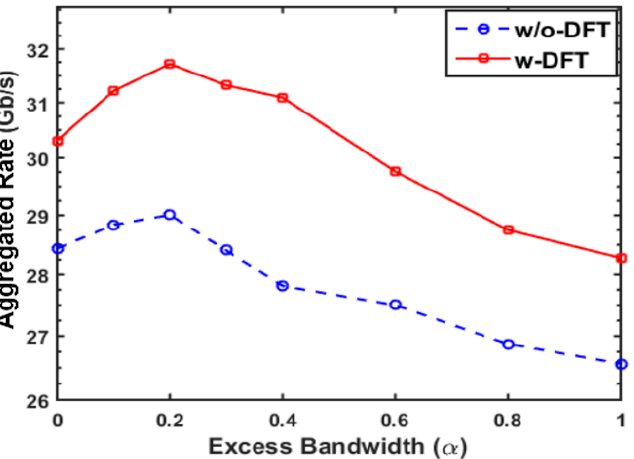
Figure 6. Aggregated rate versus excess bandwidth over a 25 km SSMF IMDD PON transmission system when a 7-bit resolution is considered.